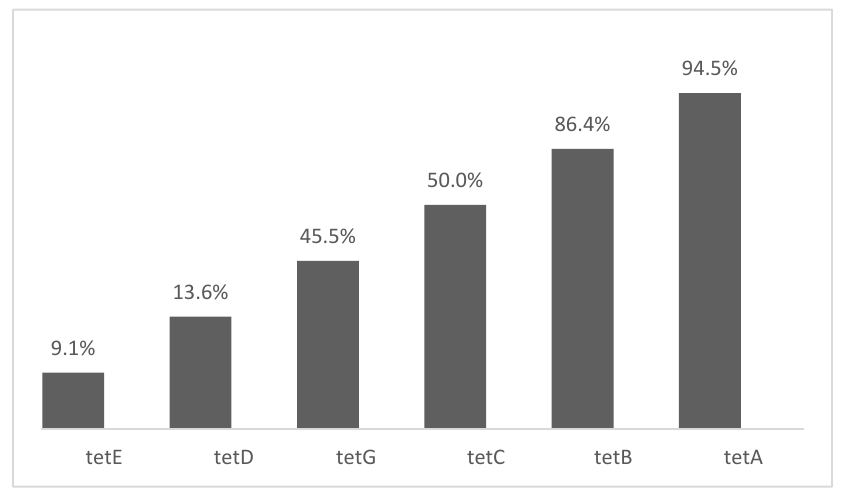
Figure 1. Percentage of studies that searched for tetracycline resistance genes.